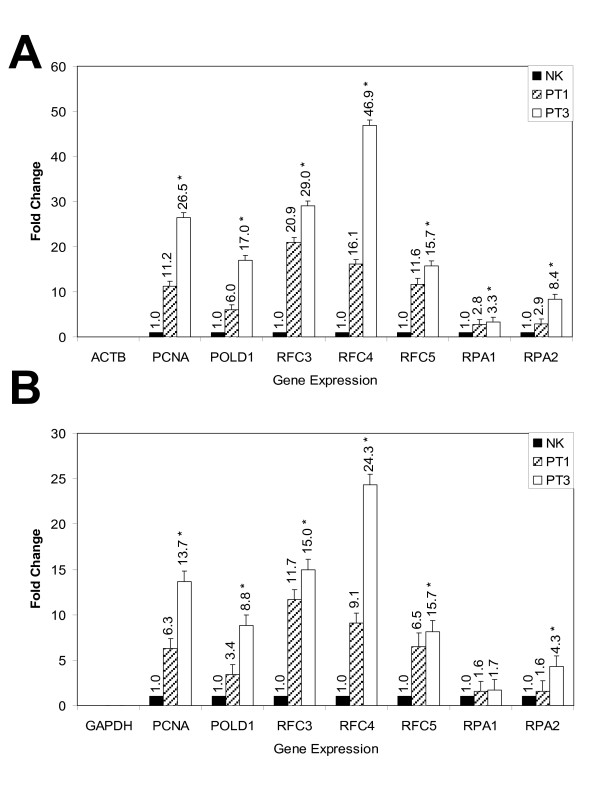
Real-time quantitative PCR analysis of differentially expressed transcripts in NK, PT1 (upward diagonal bars) and PT3 (open bars). Data are expressed relative to ACTB (2A) and GAPDH (2B) mRNA and (*) presented p < 0.05. Fold-expression changes were calculated using the equation 2-ΔΔCT [5]. Error bars for each column in the plot provided that the associated expression level was calculated from 3 replicates. The error bars display the calculated maximum (RQMax) and minimum (RQMin) expression levels that represent standard error of the mean expression level (RQ value). Collectively, the upper and lower limits defined the region of expression within which the true expression level value was likely to occur. The error bars was based on the RQMin/Max confidence level. The number associated with each bar indicates the linear fold-change of mRNA expression in PT1 and PT3 relative to NK for comparison.